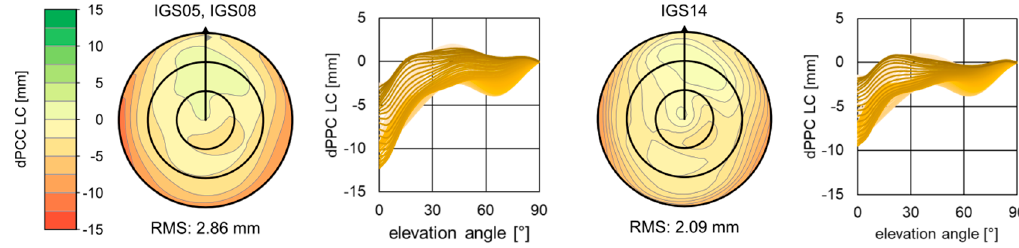
Figure 7. Difference in phase centre correction between individual model (#SN: 40012, mounted at OST6, Sweden) and International GNSS Service (IGS) type mean consecutive releases (IGS05, IGS08, and IGS14).